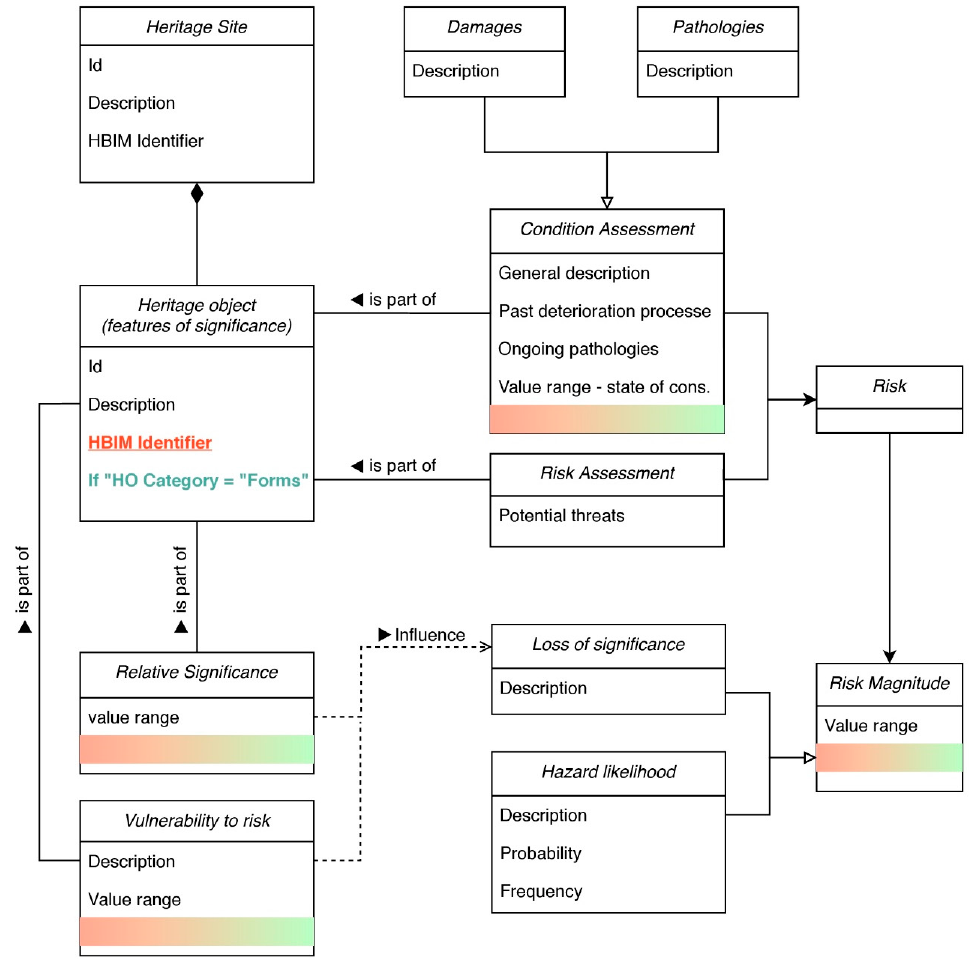
Figure 9. Structuring of data for the risk assessment centreed on a heritage object. The HO is associated with specific threats to its integrity (determined by risk and condition assessment) and a relative value is given to the magnitude of the risk (affected by the probability of the risk, the potential loss of significance (influenced essentially by the significance of HO and its vulnerability to the risk) and the portion of the features impacted.